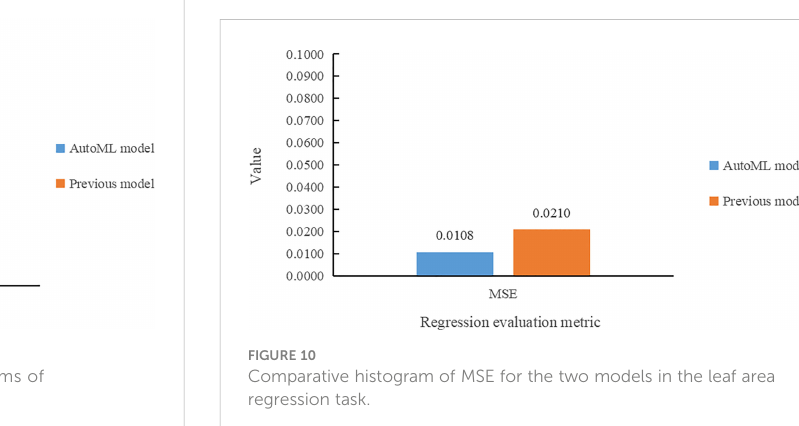
FIGURE 8 Comparative histogram of the two models in terms of classi fi cation accuracy.